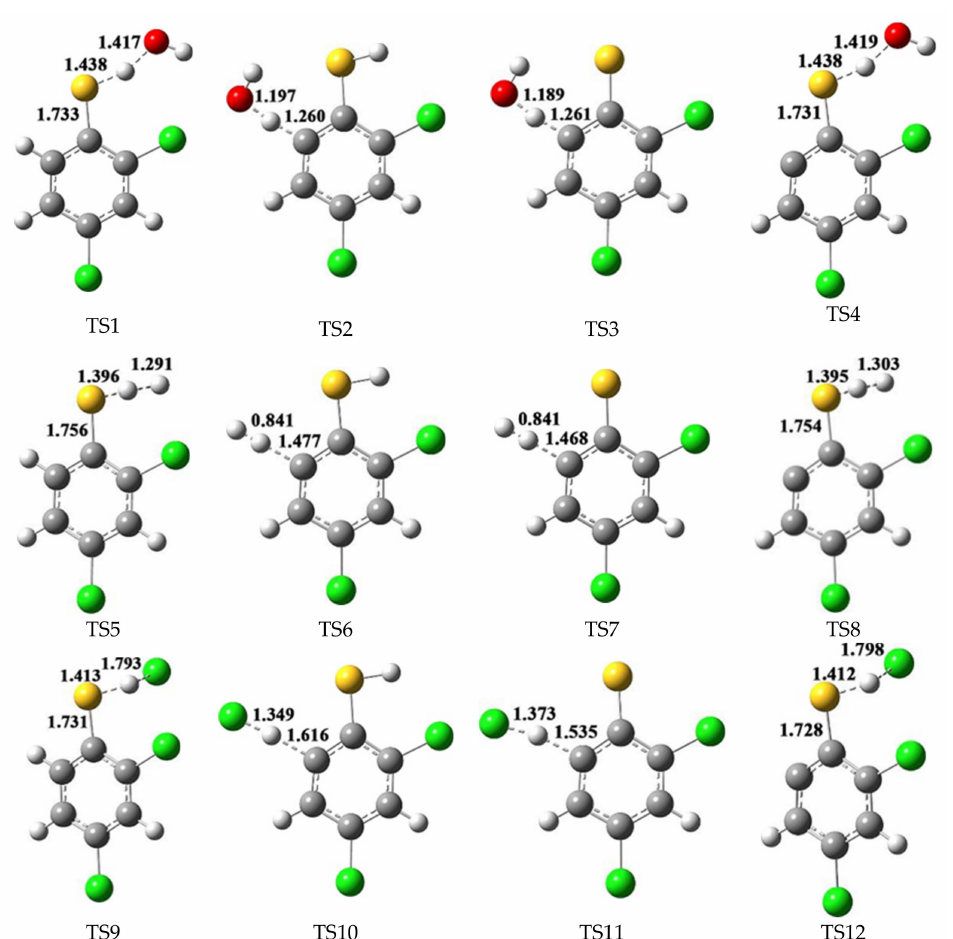
Figure 2. MPWB1K / 6-31 + G(d,p) optimized transition state geometries for reactions between 2,4-DCTP with OH, H and Cl radicals. The bond distances are given in Å. Green, gray, yellow, red and white balls denote Cl, C, S, O and H atoms,